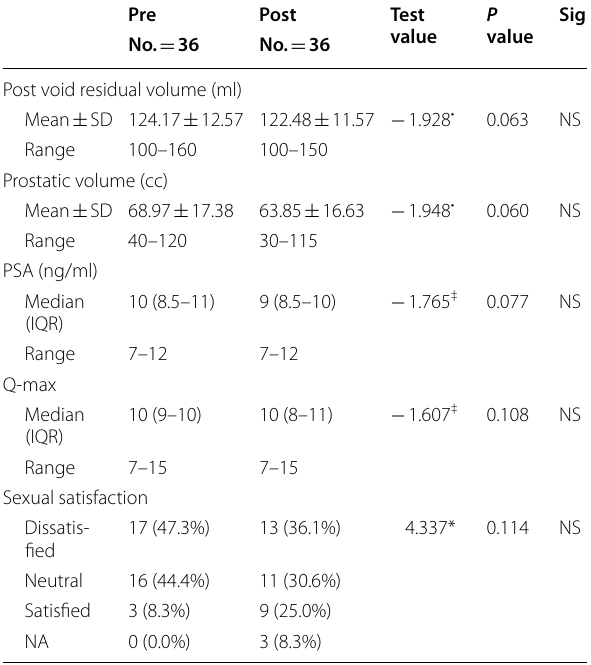
Table 2 Demonstrates the statistical analysis of the changes in the degrees of sexual satisfaction, prostatic volumes, post-void residual volumes, maximum urinary flow rates, and PSA levels pre and post